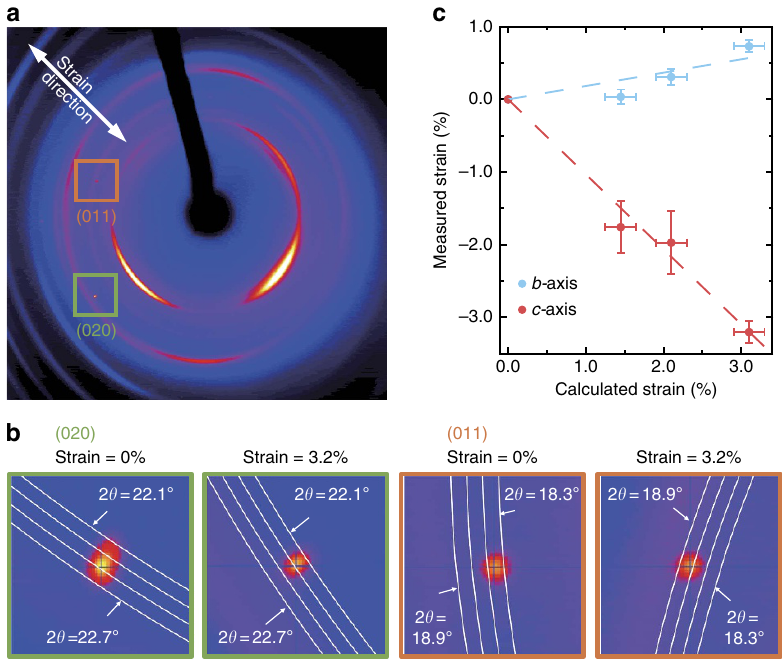
Figure 3 | Crystal structure under strain. ( a ) Transmission XRD patterns of a strained single-crystal semiconductor thin film (calculated strain ¼ 3.2%). The broad ring-like features stem from the PEN substrate and the polymer insulator (Supplementary Fig. 8). Clearly distinct single peaks are observed, confirming that the thin films are in fact single crystals. ( b ) When strained, the 011 and 020 peaks shift from 22.467 (cid:2) to 22.282 (cid:2) and from 18.434 (cid:2) to 18.741 (cid:2) , respectively, confirming that the strain is applied homogeneously throughout the single crystal. ( c ) Decrease of the c -axis and elongation of the b -axis under strain. The bottom axis shows the applied strain along the c -axis calculated from the bending radius and equation (2). The left axis is the induced strain along the b - and c -axes measured by XRD. The horizontal error bars show the uncertainty of the calculated strain originating from the sample holder design. The vertical error bars are the s.d. of the measured strain stemming from the variation of the diffraction peaks among different crystal domains and multiple